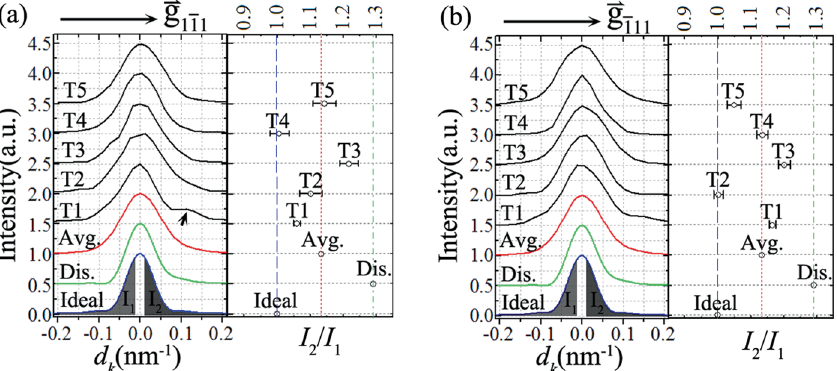
Figure 5. Comparison of intensity line profiles between experiment and simulation. ( a ) and ( b ) demonstrate the intensity line profile of the (331) reflection, along the direction parallel to The experimental line profiles represented by black curves (T1~T5) are extracted from the reconstructed 2D intensity map shown in Fig. 3(b) as indicated by white dashed line with arrow. The red curve is an average (Avg.) of the ten experimental intensity profiles. The experimental intensity profiles are vertically offset and compared with the kinematically simulated result for the ideally unrelaxed structural model (Ideal, blue curve) and the star-disclination model (Dis., green curve). In the right part of ( a ) and ( b ), the ratio of the intensity integration along positive deviation ( I 2 ) to that along negative deviation ( I 1 ) is demonstrated for each intensity